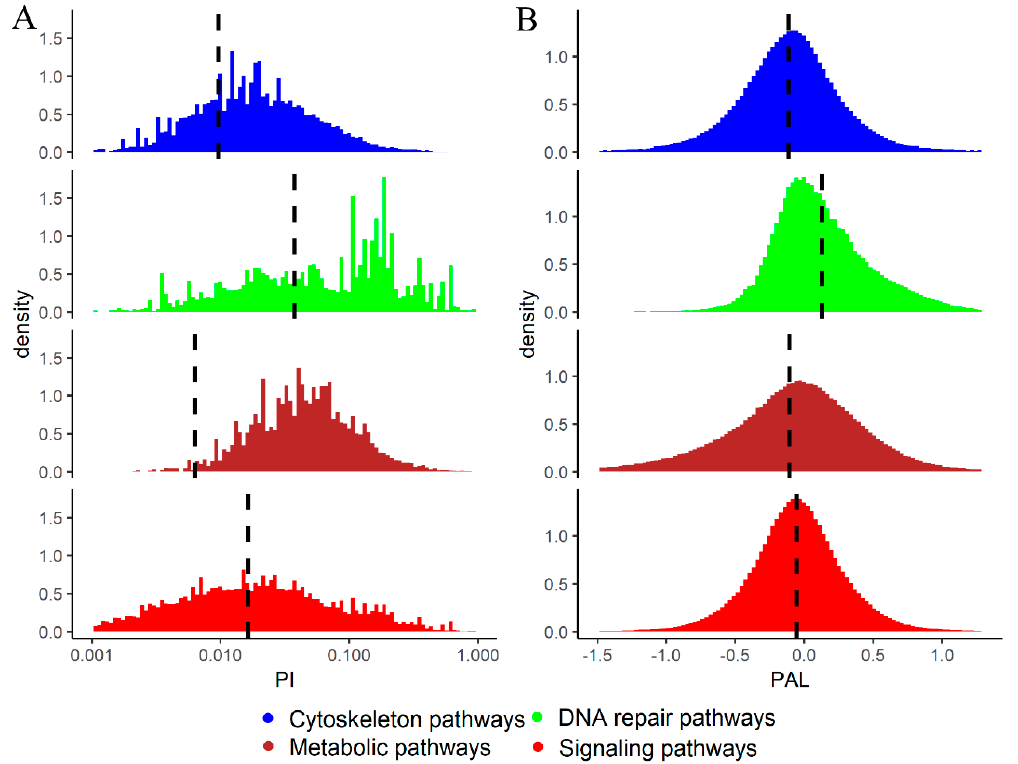
Figure 5. ( A ) Distributions of PI > 0 scores for cytoskeleton, metabolic, DNA repair and signaling molecular pathways in 4910 cancer samples. PI axis is given in logarithmic scale. Vertical dashed lines show mean PI values calculated for all cases including PI = 0. ( B ) Distributions of PAL scores for cytoskeleton, metabolic, DNA repair and signaling molecular pathways in the same cancer samples. Vertical dashed lines show mean PAL values calculated for the respective group of pathways for all tumor samples.